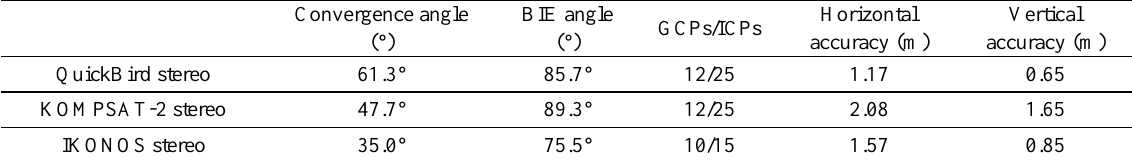
Table 2. Imaging geometry and positioning accuracy for the single-satellite stereo images.